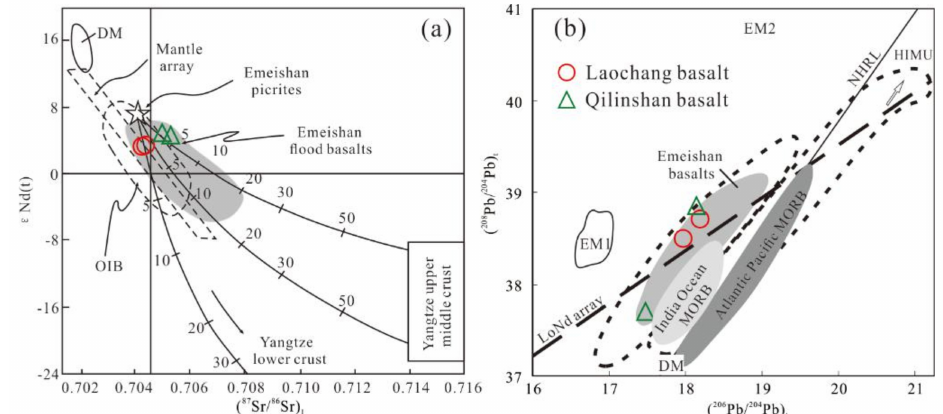
Figure 6. ( a ) ( 87 Sr / 86 Sr)i vs. ε Nd(t) diagram (modified from [3]), OIB: ocean island basalt; ( b ) ( 206 Pb / 204 Pb)t vs. ( 208 Pb / 204 Pb)t diagram ( t = 244 Ma, modified from [38]), EM1: enriched mantle 1, EM2: enriched mantle 2, DM: depleted mantle, HIMU: high 238 U / 204 Pb mantle end member, NHRL: northern Hemisphere reference line; data of Emeishan basalts from